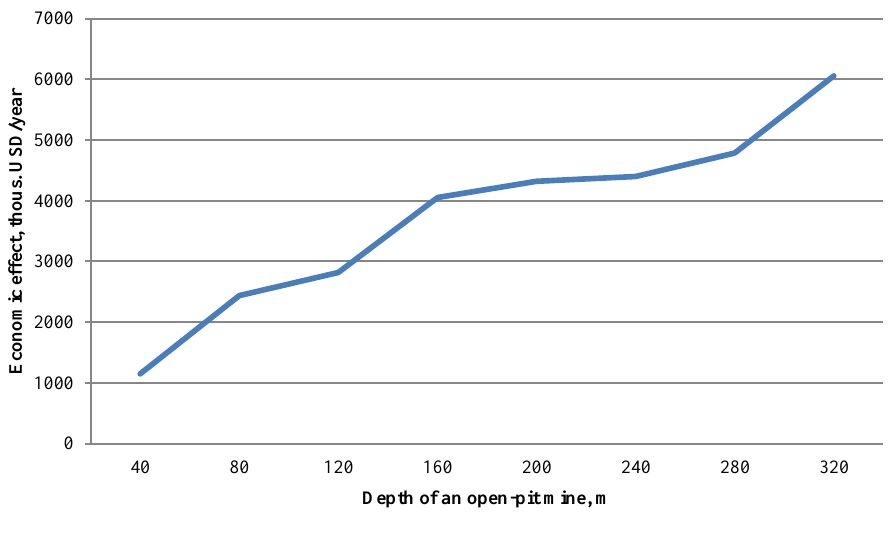
Fig. 7. Dependence of the economic efficiency of introduction of the container technology on the depth of an open-pit